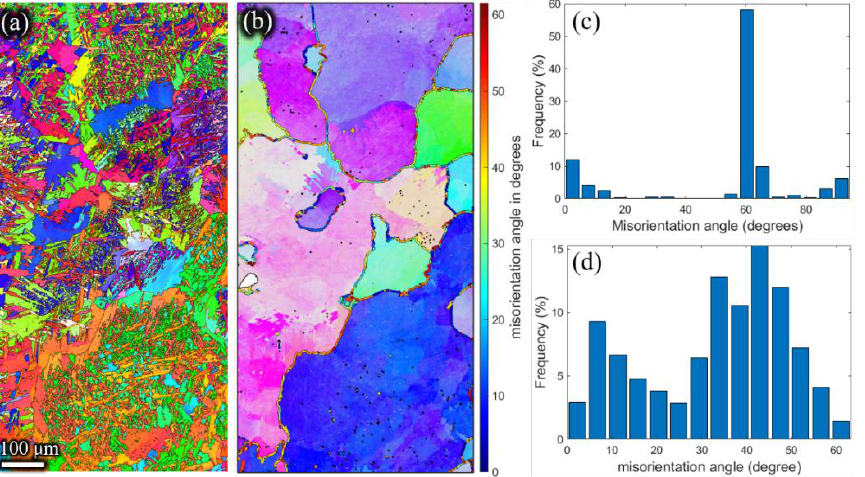
Figure 13. Inverse pole Figures of ( a ) the α phase, and ( b ) the reconstructed β phase. Misorientation angle of ( c ) α grains, and ( d ) reconstructed β grains of the residual deformed billet with a holding time of 120 s.